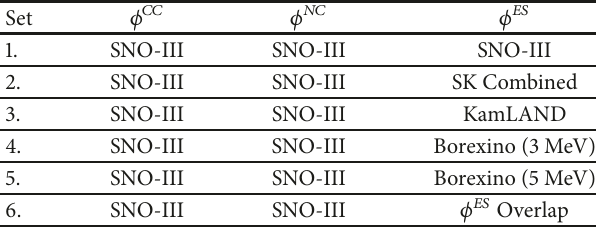
Table 4: Grouping of data in different sets. Table 5: Cross-sectional ratios for various